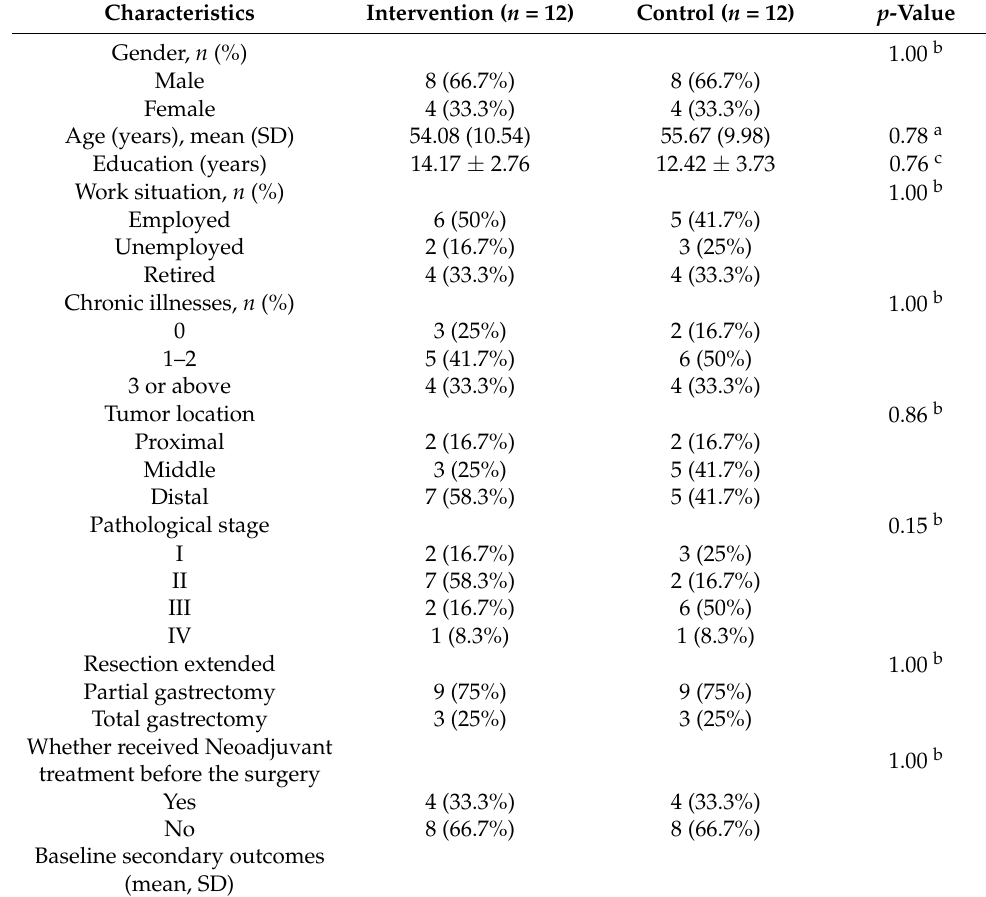
Table 1. Demographic, clinical data, and outcomes at baseline.